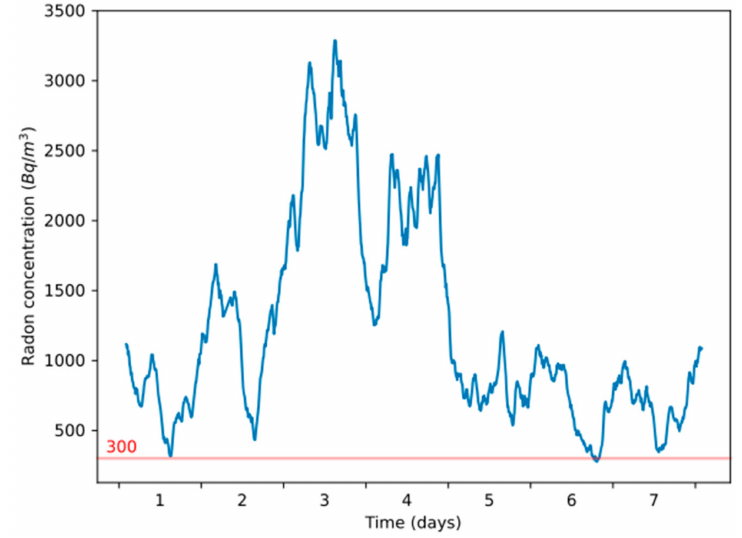
Figure 4. Radon concentration during a week without the air quality control system